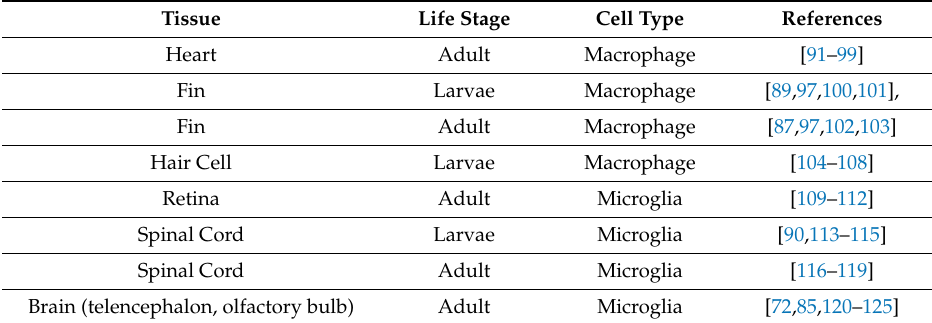
Table 1. Zebrafish Regeneration Studies on Macrophage and Microglial